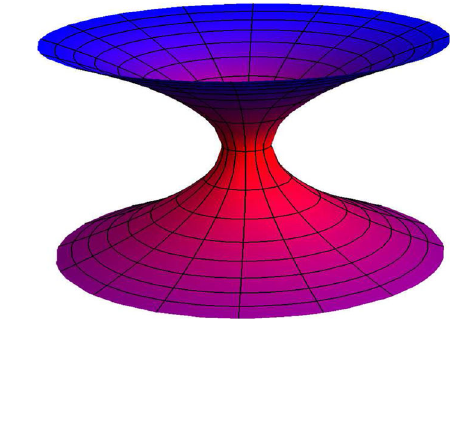
Fig. 1 shows the evolution of embedding